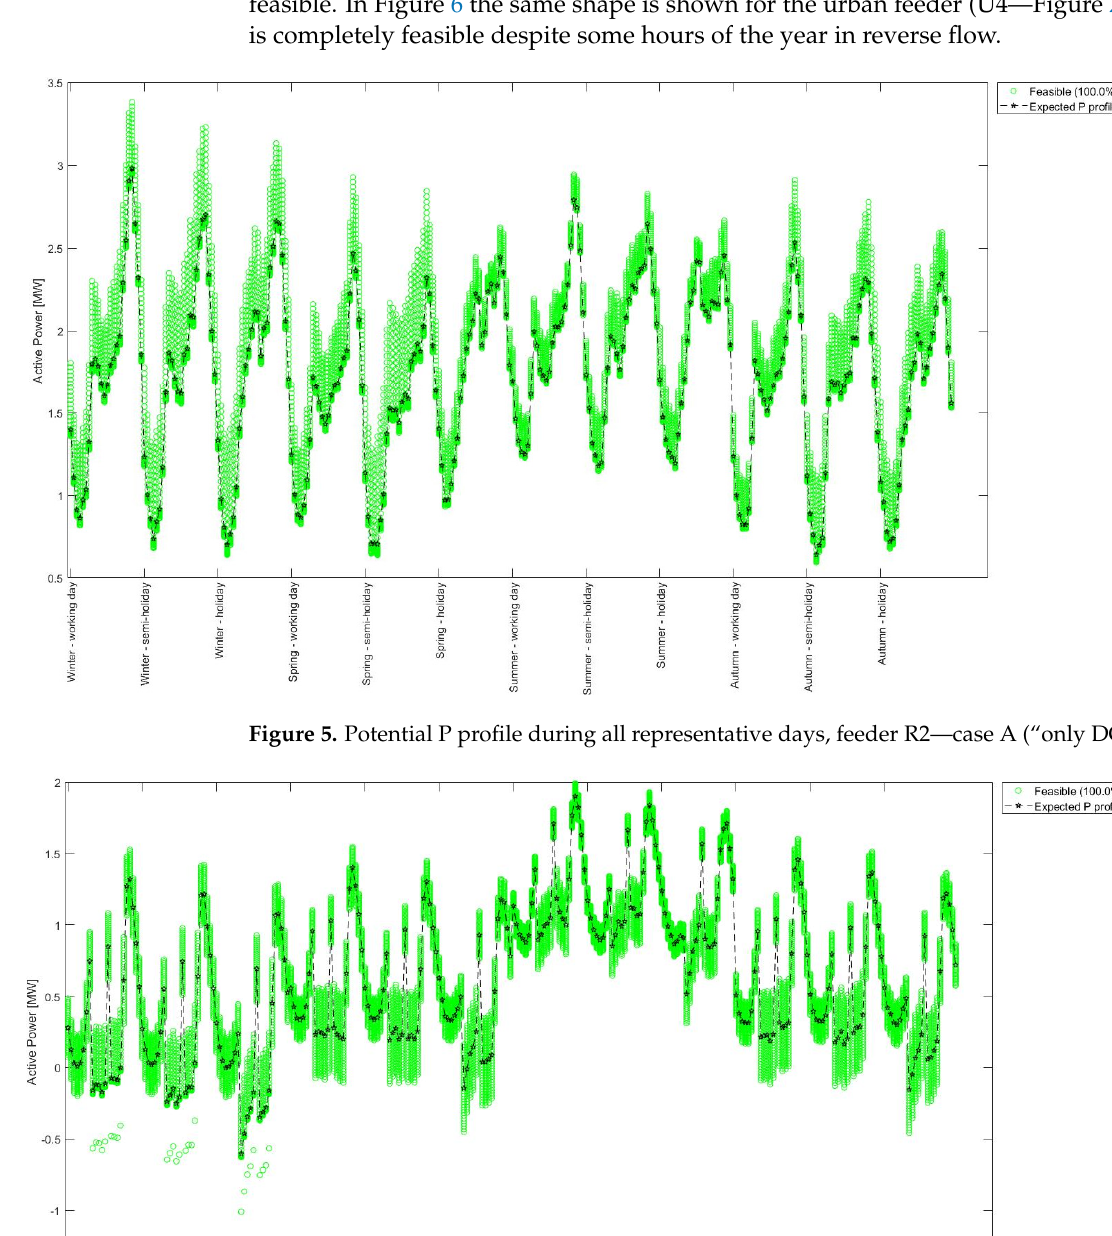
Figure 4. Potential P profile during all the representative days, feeder R1—case A (“only DG”).